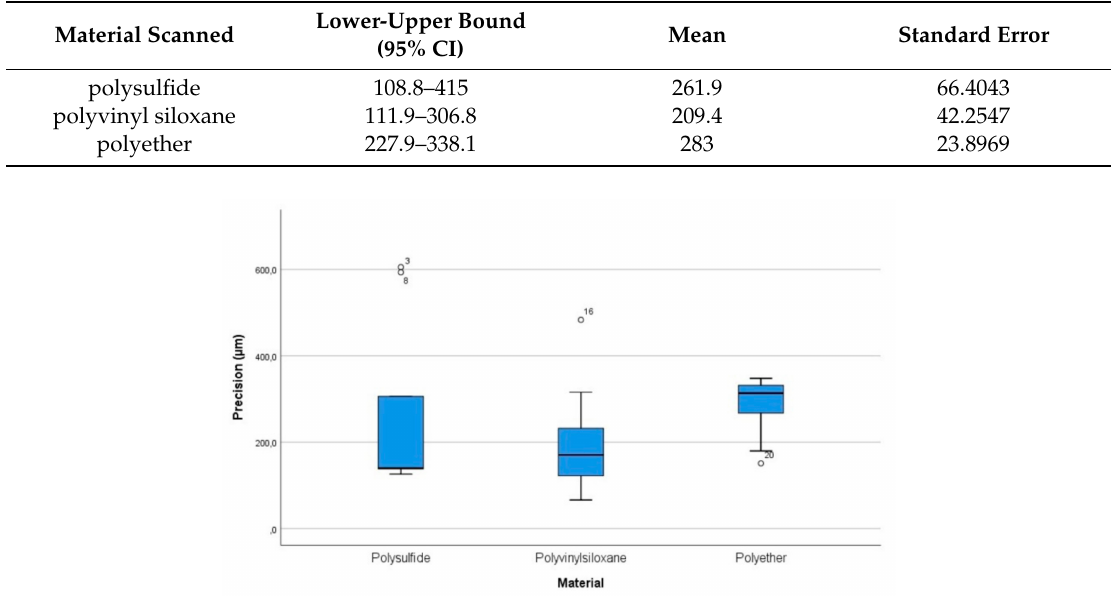
Figure 7. Box plot chart of precision values. The central rectangle spans the first quartile to the third quartile and whiskers above and below the box show the locations of the minimum and maximum. The segments inside the rectangle shows the median, and unfilled circles represent suspected